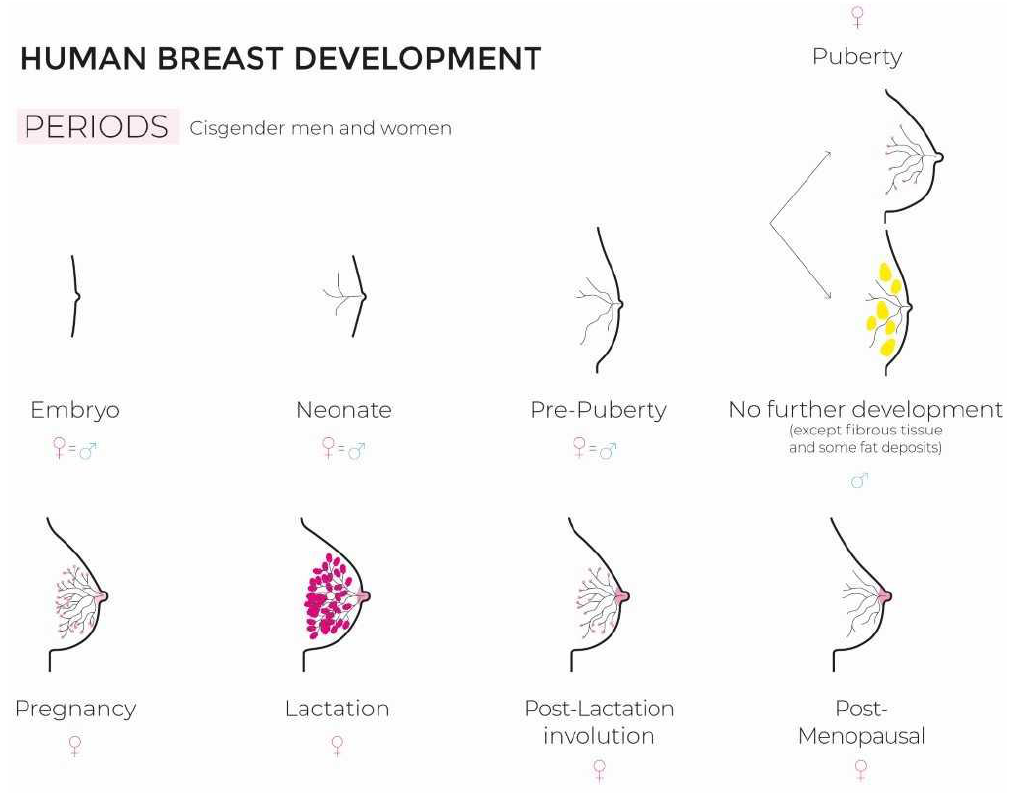
Figure 1. Human breast development (figure created by Florence Boulvain).